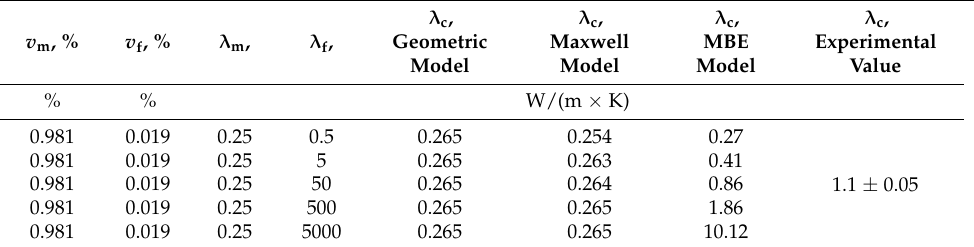
Table 2. The results of calculations of the thermal conductivity of the composite with 1 wt. % FLG for various models depending on the thermal conductivity of FLG